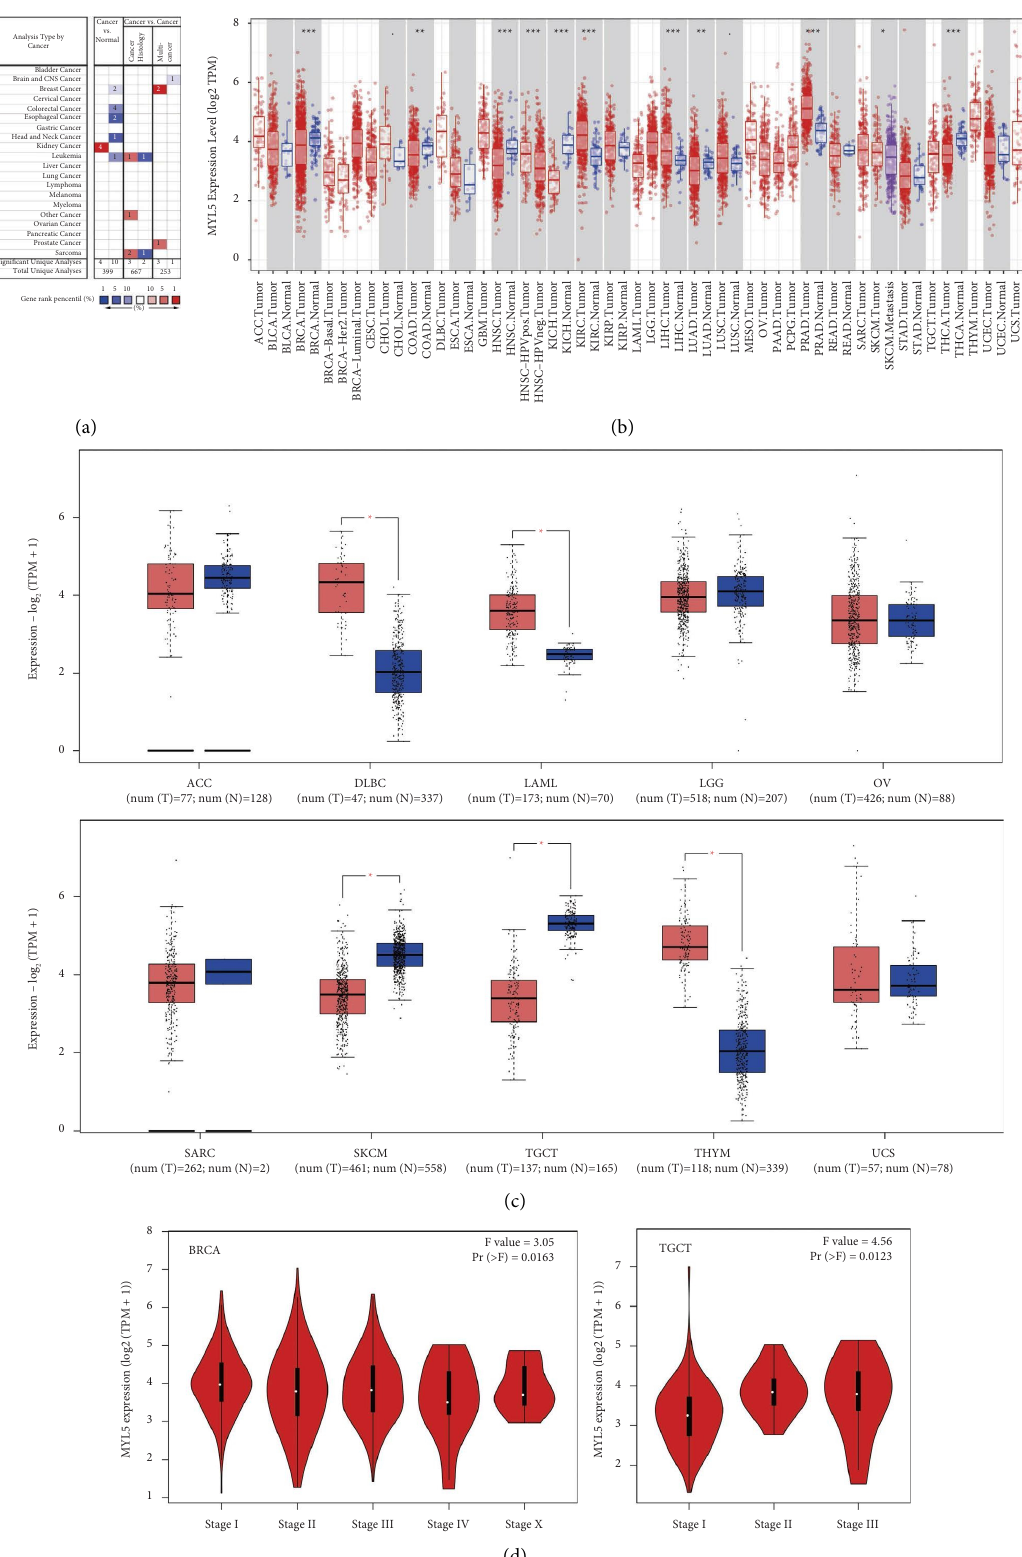
Figure 1: Te expression levels of the MYL5 gene in pan-tumors and normal tissues. Te expression levels of MYL5 in diferent types of tumor tissues and normal tissues were analyzed by using the Oncomine database (the threshold of p value is 0.01, fold change is 2, and gene ranking is all) (a), TIMER 2.0 (b) and GEPIA2 (c) tools (d). Te expression levels of the MYL5 gene were analyzed by the main pathological stages of BRCA and TGCT. Log2 (TPM+ 1) was applied for the log-scale. ∗ p < 0 . 05, ∗∗ p < 0 . 01, and ∗∗∗ p < 0 .